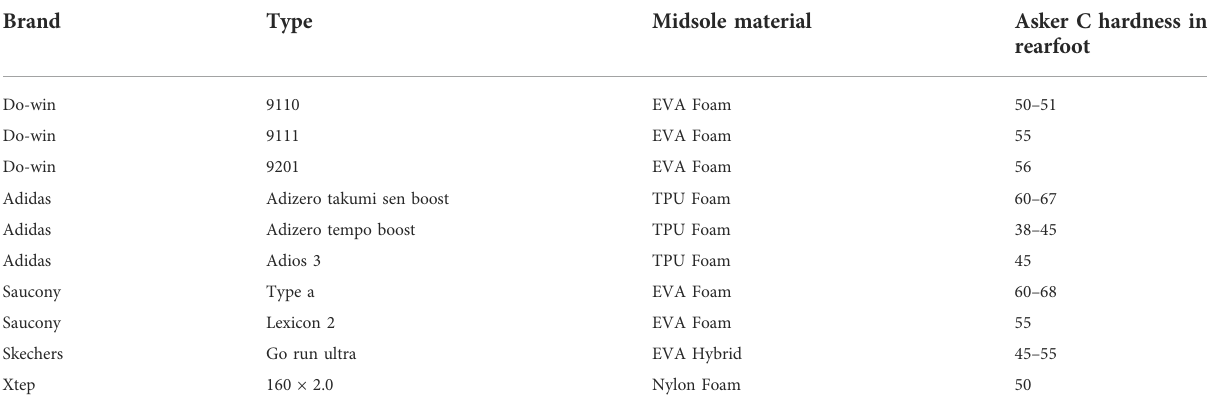
TABLE 6 Hardness characteristics of midsole materials of some sport shoes (Fu et al.,